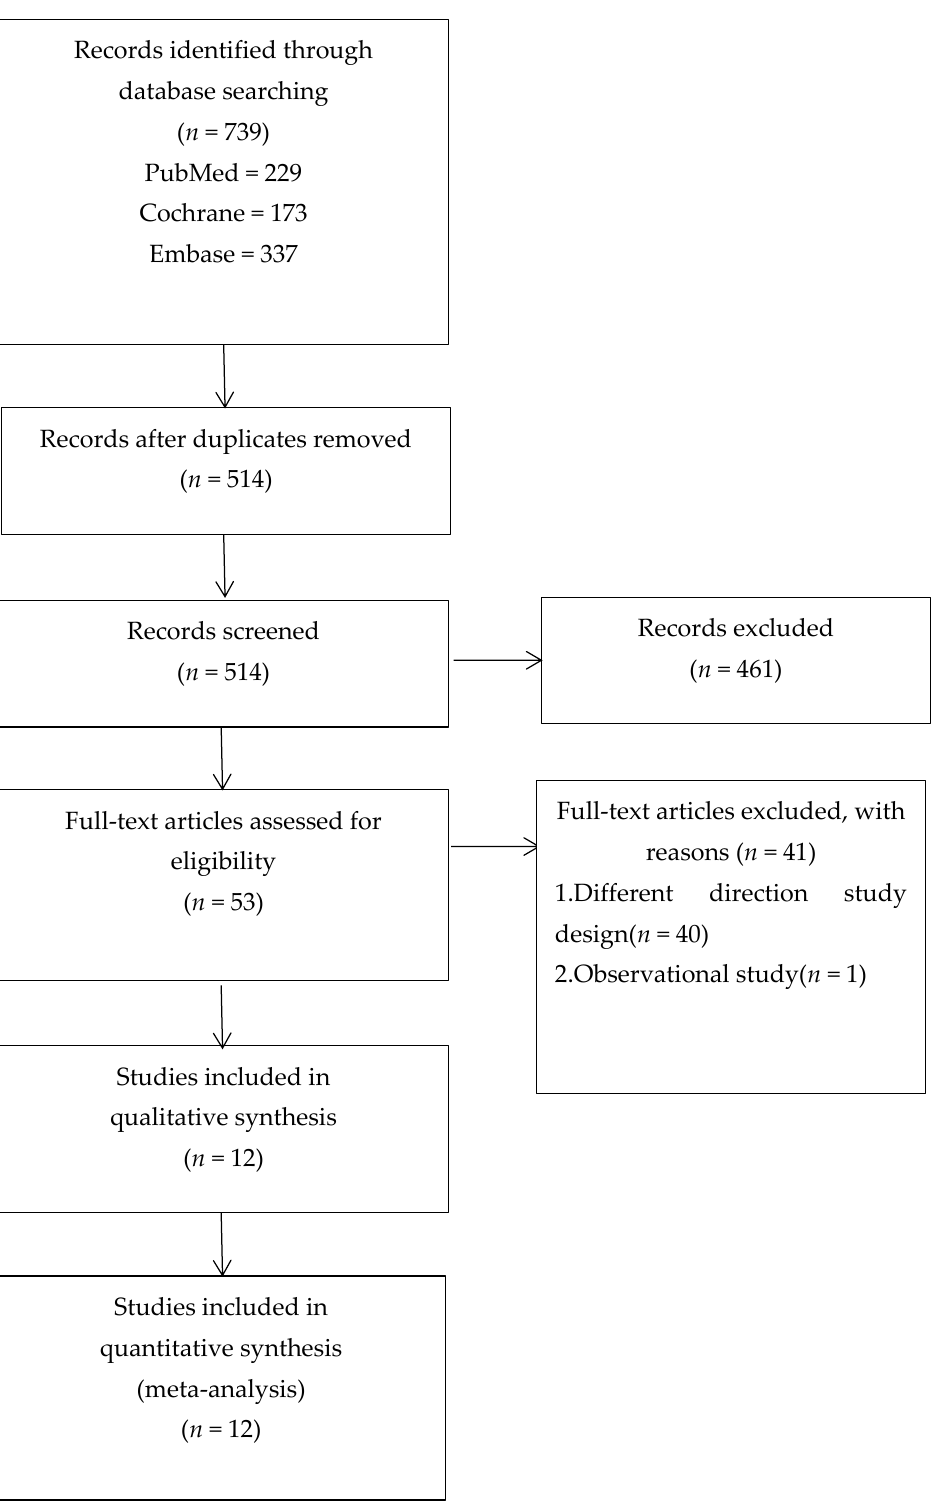
Figure 1. PRISMA flow diagram.